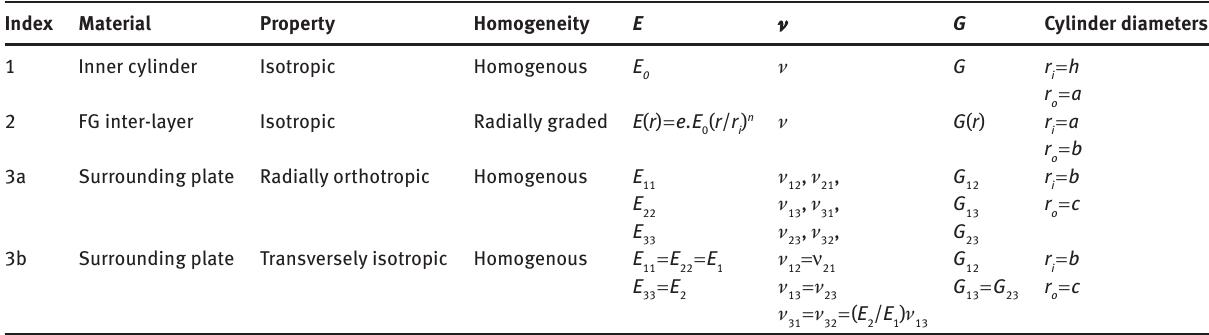
Table 1: Material properties of the joint